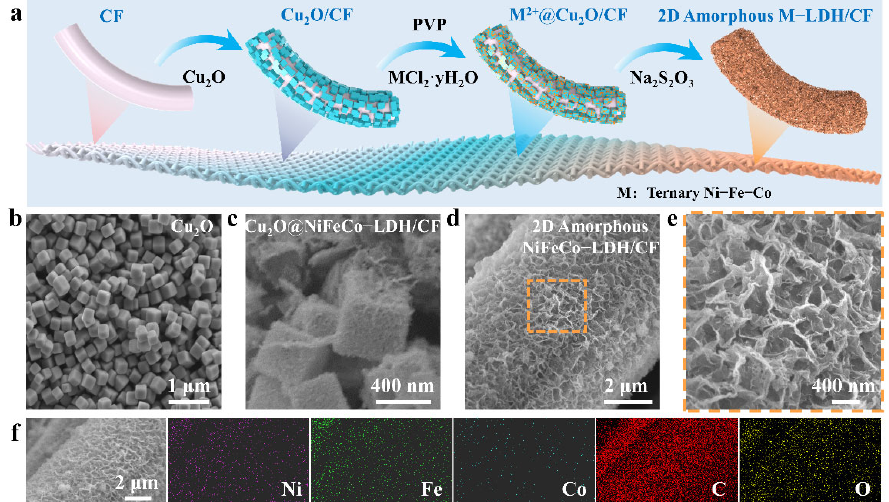
Figure 2. Preparation and morphology characterization of NiFeCo ‐ LDH. ( a ) The general preparation process of NiFeCo ‐ LDH. ( b – d ) SEM images of Cu 2 O, Cu 2 O@NiFeCo ‐ LDH/CF, and NiFeCo ‐ LDH/CF. ( e ) Partial enlargement of NiFeCo ‐ LDH/CF. ( f ) The element distribution of NiFeCo ‐ LDH/CF. X ‐ ray diffraction (XRD) patterns are used to analyze the crystal structure changes of samples during the reaction process. As shown in Figure 3a, the diffraction characteristic peaks located at 29.9°, 37.0°, 42.5°, 62.4°, and 74.4° in the XRD diffraction pattern well correspond to the cubic phase Cu 2 O (PDF: 00–005–0667) [28], which proves that the cubic particles with uniform morphology are successfully synthesized cuprous oxides. The XRD pattern of NiFeCo ‐ LDH/CF is similar to that of pure CF. There is no obvious diffraction peak, indicating that the prepared sample presents an amorphous nature [29]. This disor ‐ dered structure and irregular surface provide a high degree of activity and exposure to abundant active sites. The amorphous state can also promote good mass transfer and pro ‐ vide more stable performance [30]. The X ‐ ray photoelectron spectrometer (XPS) test was used to verify the chemical composition of NiFeCo ‐ LDH/CF. The presence of Ni, Fe, Co, O, and C in NiFeCo ‐ LDH/CF is further confirmed by the wide ‐ sweep measurement spec ‐ and 855.9 eV, corresponding to Ni 2p 1/2 and Ni 2p 3/2 , respectively, which are attributed to